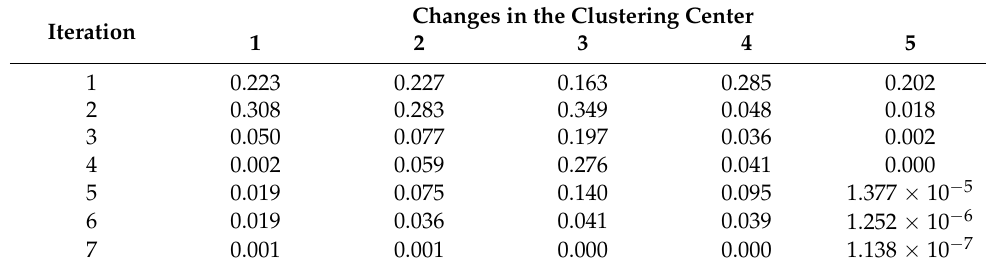
Table A6. Iteration history records.